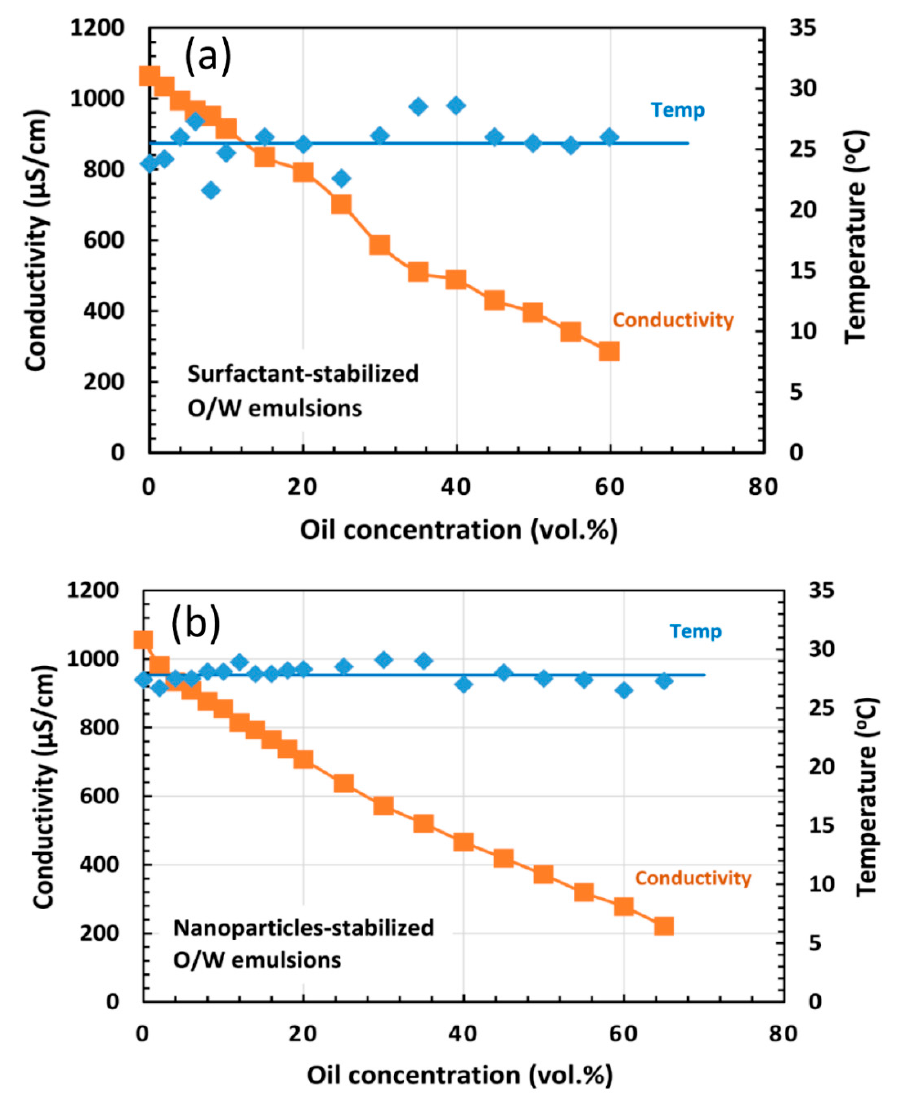
Figure 5. Variations of temperature and electrical conductivity of ( a ) surfactant-stabilized and ( b ) nanoparticle-stabilized O/W emulsions with the increase in oil